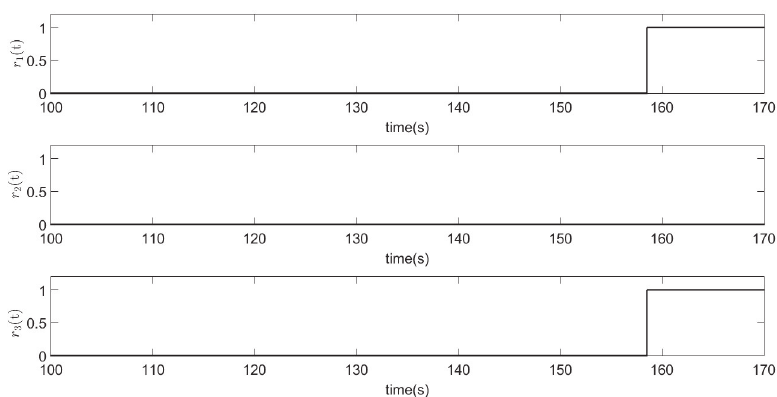
Figure 12. Normalized residual evaluation in case 4 (fault at actuator 1, f a 1